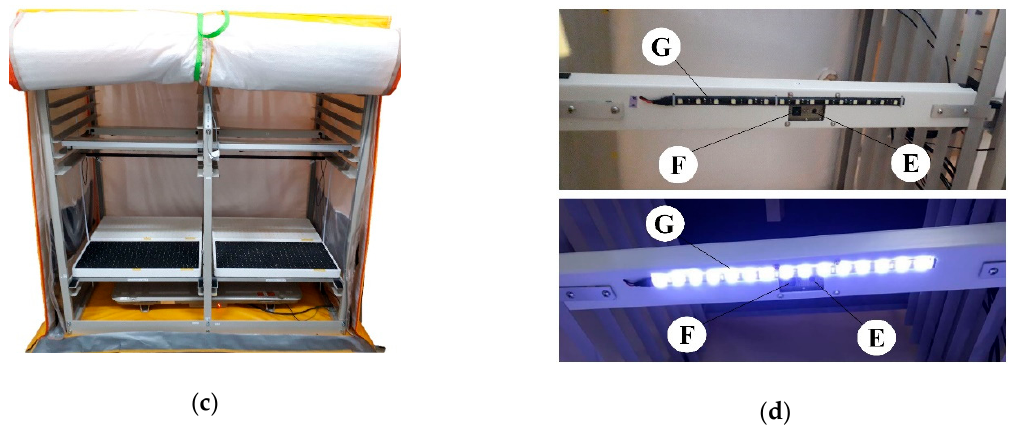
Figure 1. Germination container box (GCB) equipped with phenotyping and microenvironmental sensing units. ( a ) Schematic diagram. 1) Temperature control unit: Air conditioner ( A ), Air outlet of air conditioner ( B ), Electric heater ( C ). 2) Phenotyping unit: Control board (×4) ( D ), Red-green-blue (RGB) camera (×4) ( E ), Thermal camera (×4) ( F ), White light emitting diode (LED) for flash (×4) ( G ). 3) Air temperature/relative humidity sensor (×4) ( H ). 4) Cultivation unit: Seed tray with substrate (seed